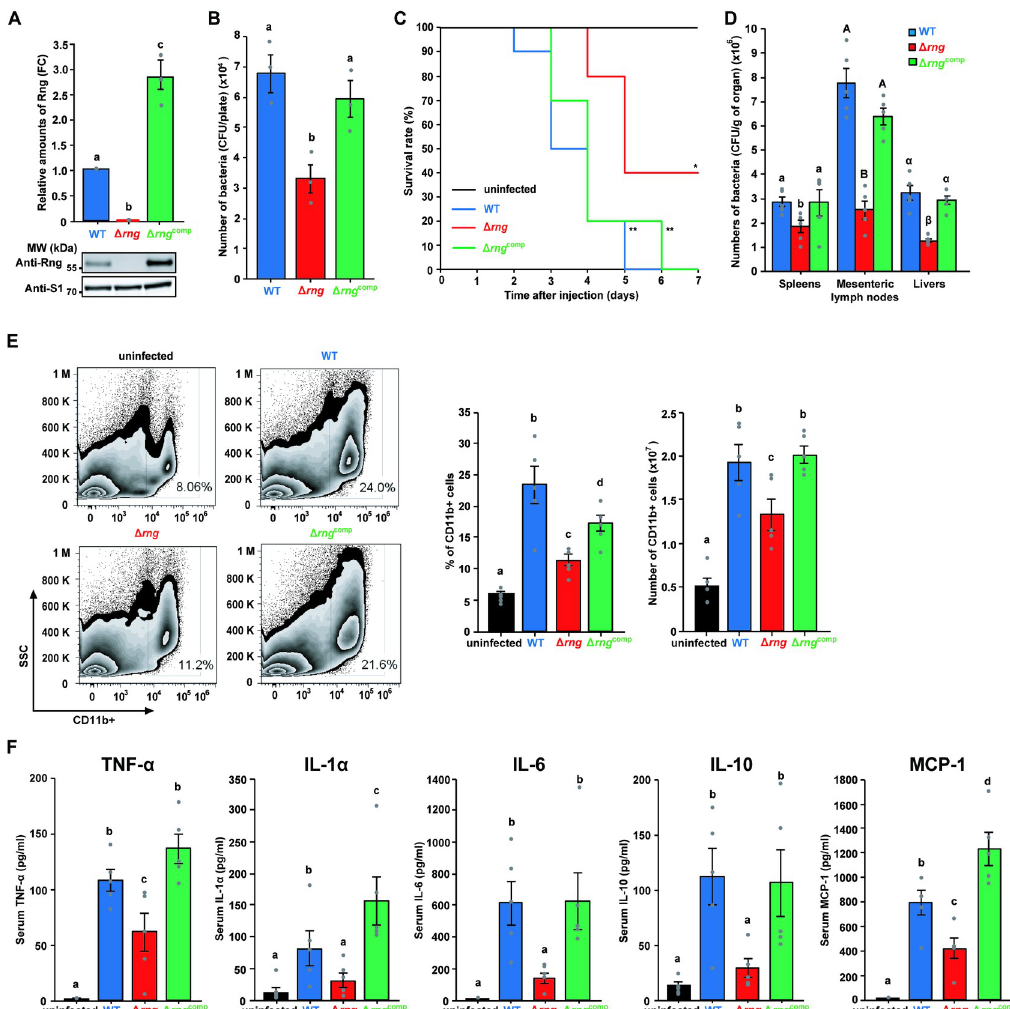
Fig 1. Effect of RNase G on S . Typhimurium pathogenicity. (A) Western blot analysis of Rng in S . Typhimurium strains (WT, Δ rng , and Δ rng comp ). WT Rng levels were set to 1 and ribosomal protein S1 was used as an internal standard. (B) Effect of rng expression on S . Typhimurium epithelial cell invasion. Epithelial cells (HCT116) were infected with the S . Typhimurium cultures used in (A) at a multiplicity of infection (MOI) of 100 and the number of intracellular bacteria counted as CFUs. For (A) and (B) , data present the mean ± s. e. m. of at least three independent experiments. Statistically significant differences are indicated by different letters. Western blot data were analyzed by one-way analysis of variance (ANOVA) with Student- Newman-Keuls test, P < 0.0001. Epithelial cell invasion data were analyzed using the one-way ANOVA with Student-Newman- Keuls test, P < 0.05. (C) Survival rate and duration of BALB/c mice infected with S . Typhimurium strains (WT, Δ rng , and Δ rng comp ) and PBS as a control. Survival was monitored for 7 days ( n = 10 per group). � P < 0.05 and �� P < 0.01 for WT-, Δ rng -, or Δ rng comp -infected mice vs. PBS-treated mice (two-sided unpaired Student’s t -test). (D) Colonization assay in BALB/c mice ( n = 5 per group) infected with S . Typhimurium strains (WT, Δ rng , and Δ rng comp ). Bacterial CFUs were counted in the spleens, livers, and mesenteric lymph nodes. Data represent the mean ± s. e. m. of at least three independent experiments. Statistically significant differences by one-way ANOVA with Student-Newman-Keuls tests ( P < 0.0001) are indicated by different letters: small letters indicate a difference from the spleens; large letters indicate a difference from the mesenteric lymph nodes; Greek symbols indicate a difference from the livers. (E) Flow cytometry analysis of innate myeloid immune cells (CD11b +) in mouse splenocytes from BALB/c mice infected with or without S . Typhimurium strains (WT, Δ rng , or Δ rng comp ). Cell numbers were calculated from total splenocyte counts. (F) Serum inflammatory cytokine (TNF- α , IL-1 α , IL-6, IL-10, and MCP- 1) levels in BALB/c mice infected with or without S . Typhimurium strains (WT, Δ rng , or Δ rng comp ) for 60 h. Data represent the mean ± s. e. m. of at least two independent experiments. Statistically significant differences from one-way ANOVA with Student-Newman-Keuls tests ( P < 0.0001 for TNF- α and MCP-1; P < 0.01 for IL-1 α , IL-6, and IL-10) are indicated by different letters.